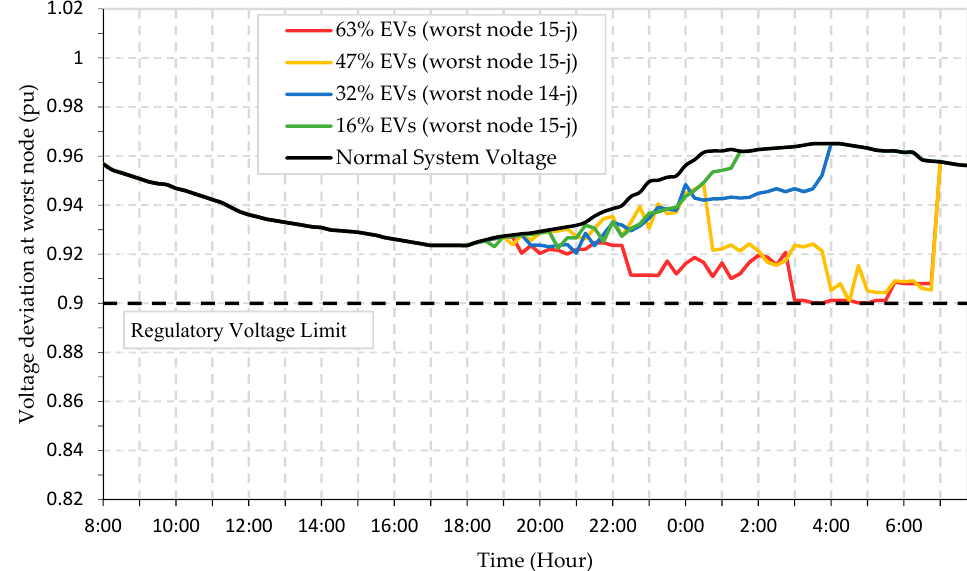
Figure 10. Impact of coordinated EVs’ charging on voltage at worst nodes.